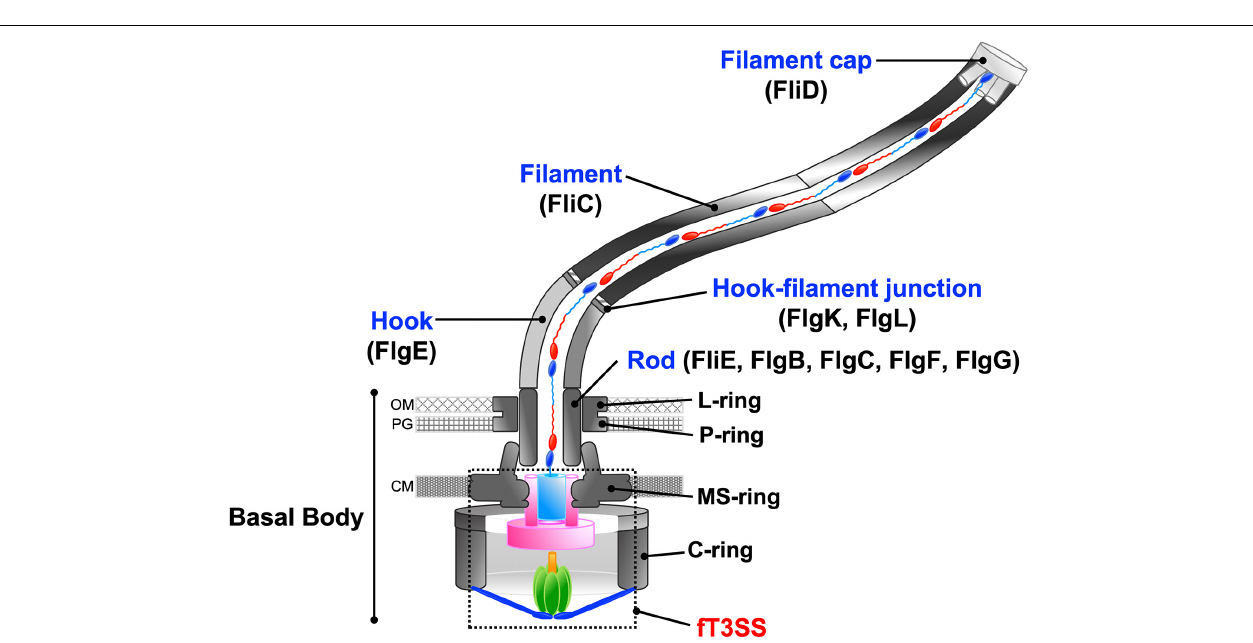
FIGURE 2 | Schematic diagram of the bacterial flagellum. The bacterial flagellum is composed of basal body rings, namely the C-ring, MS-ring, L-ring, and P-ring, and an axial structure consisting of the rod, the hook, the hook-filament junction, the filament, and the filament cap. To construct the axial structure beyond the cytoplasmic membrane, flagellar axial proteins are translocated through the fT3SS, diffuse down a narrow central channel, and assemble at the tip of the growing structure. OM, outer membrane; PG, peptidoglycan layer; CM, cytoplasmic membrane.